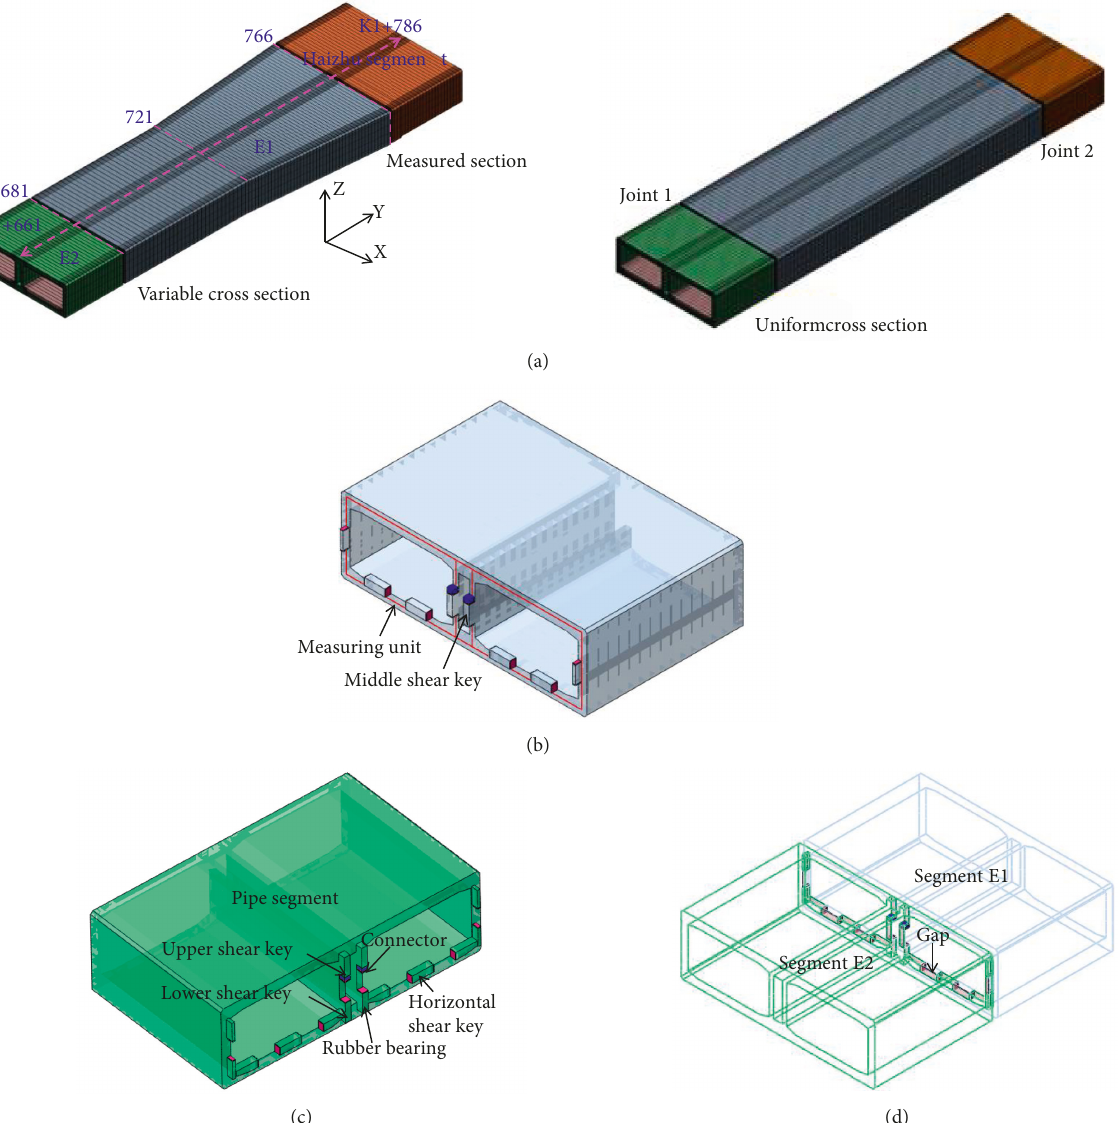
Figure 4: The three-dimensional calculation model: (a) the overall model; (b) the detailed model of the joint of segment E1; (c) the detailed model of the joint of segment E2; (d) the connection model of segments E1 and E2 with a local display of segment E1.